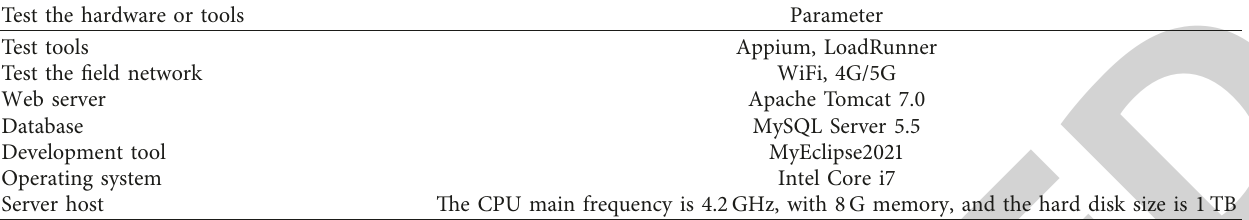
Table 2: System test environment.